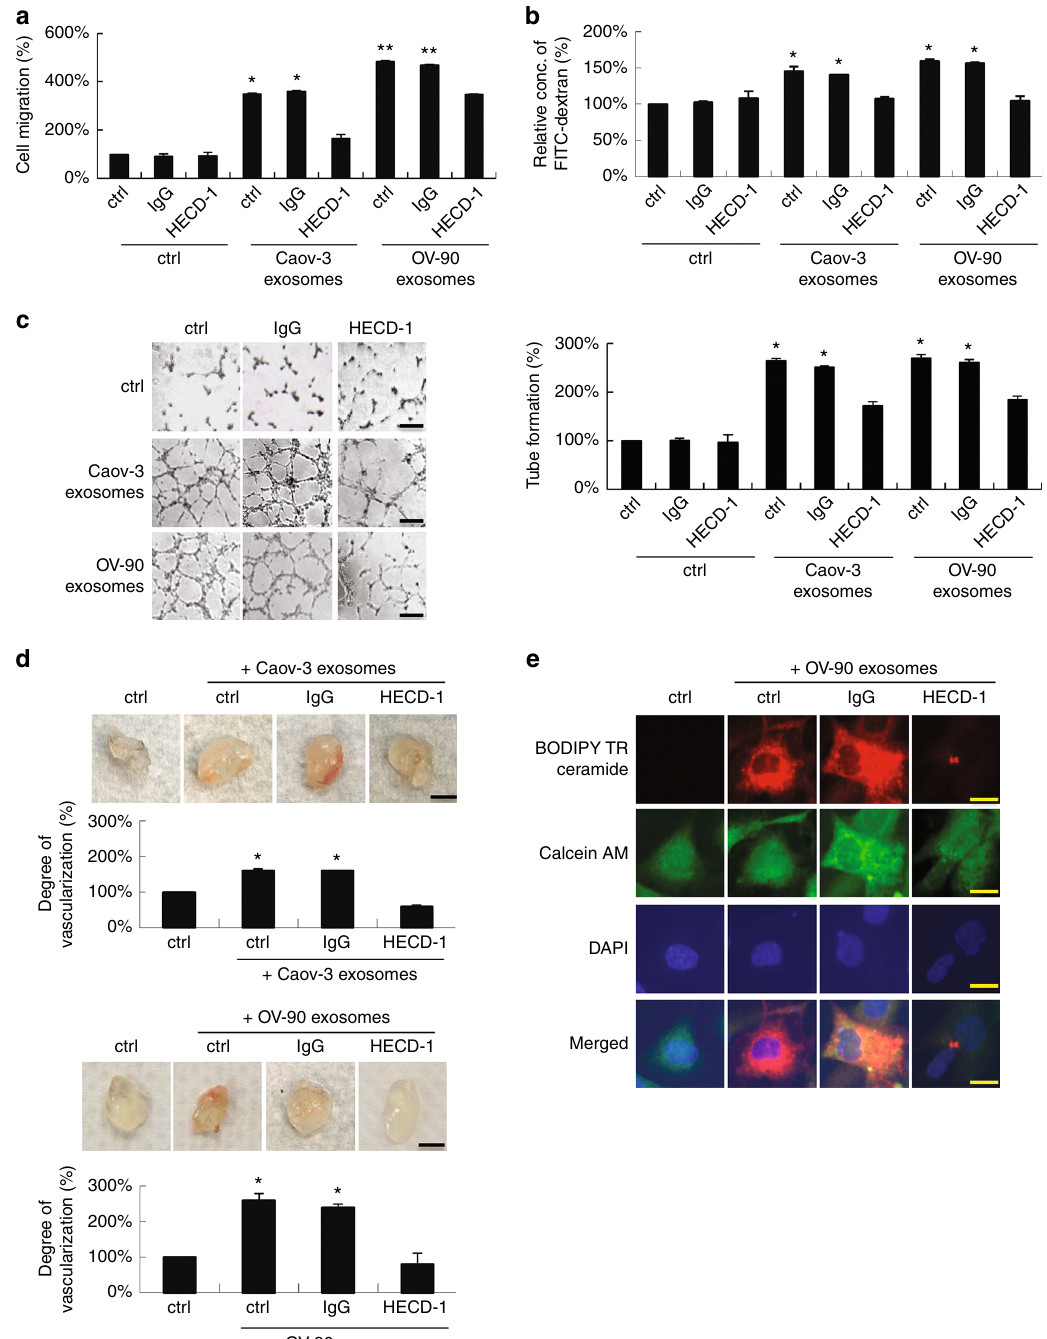
Fig. 3 sE-cad-positive exosomes promote angiogenesis in vitro and in vivo. a Cell migration assay of HUVEC treated with exosomes (25 μ g mL − 1 ) in the presence or absence of E-cadherin neutralizing antibodies, HECD-1 (100 μ g mL − 1 ). b Permeability analysis of HUVEC measured by the percentage change of FITC – dextran fl ux (excitation 485 nm, emission 535 nm) treated with exosomes (25 μ g mL − 1 ) in the presence or absence of E-cadherin neutralizing antibodies, HECD-1 (100 μ g mL − 1 ). c Tube formation assay of HUVEC treated with exosomes (25 μ g mL − 1 ) in the presence or absence of E-cadherin neutralizing antibodies, HECD-1 (100 μ g mL − 1 ). Left: Representative images of HUVEC tube formation assay. Right: Quanti fi cation of the percentage change of the number of branching points. Bar, 100 μ m. d In vivo Matrigel plug implant model using C57/BL6 mice subcutaneously injected with Matrigel containing exosomes (25 μ g mL − 1 ) in the presence or absence of E-cadherin neutralizing antibodies, HECD-1 (100 μ g mL − 1 ). In vivo neovascularization is measured by the Drabkin ’ s reagent kit 7 days after injection. Upper: Representative images of excised Matrigel plug. Lower: Quanti fi cation of the percentage change of hemoglobin content. Bar, 5 mm. e HUVECs were treated with exosomes (25 μ g mL − 1 ) in the presence or absence of E-cadherin neutralizing antibodies, HECD-1 (100 μ g mL − 1 ). Red: BODIPY TR ceramide; Green: Calcein AM; Blue: DAPI. Bar, 5 μ m. For in vivo Matrigel plug model, n = 6 per group, and were conducted twice. For the other assays, n = 3 per group, all experiments were repeated three times. Error bar indicates SD of the mean. * P < 0.05, ** P < 0.01 versus untreated control using one-way analysis of variance followed by Tukey ’ s least signi fi cant difference post hoc